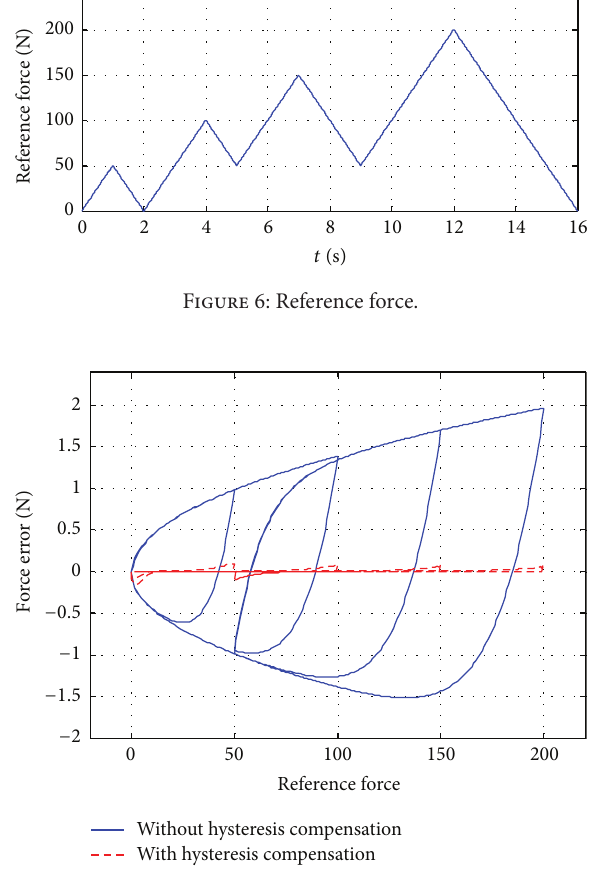
Figure 7: The maps between the reference force and the force tracking error.